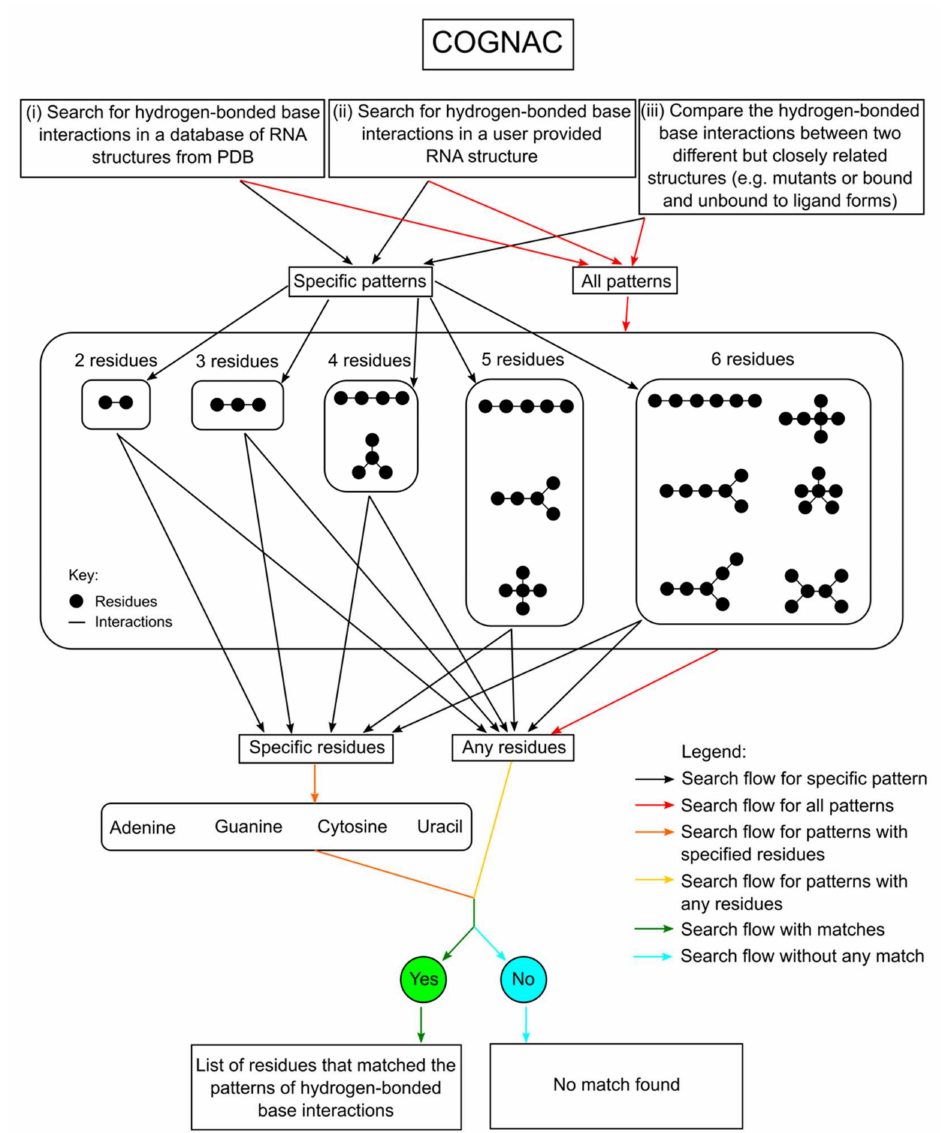
Figure 4. A flowchart that describes the search for hydrogen-bonded base interactions in RNA structures, performed by the COGNAC